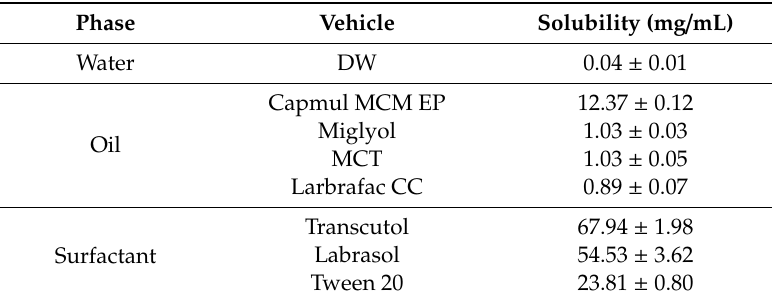
Table 1. Solubility of orobol in various